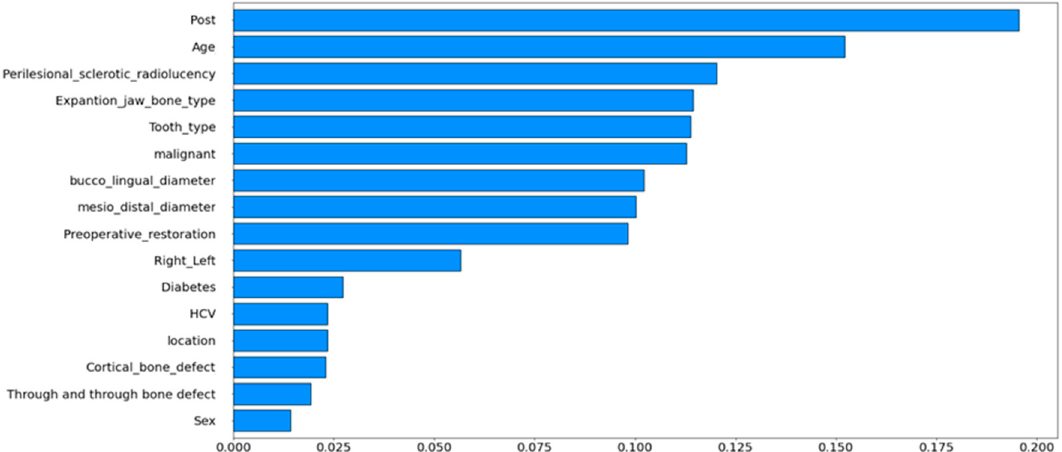
Figure 3. Diagram showing the correlation coefficients between endodontic surgical success and failure variables. The influence of the correlation coefficients is shown.